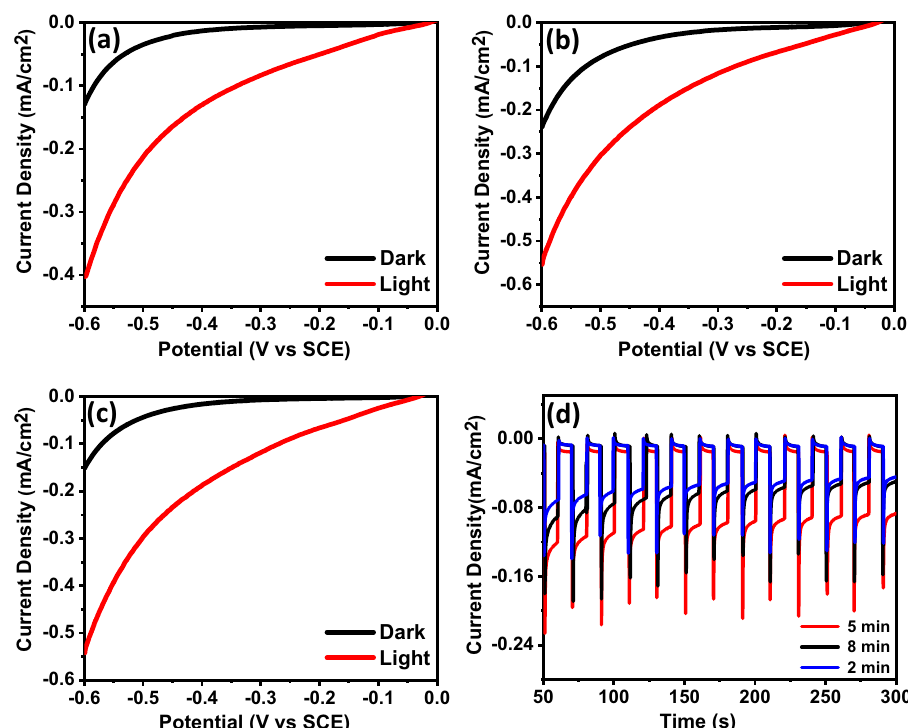
Figure 5. J–V and J–t curves of annealed Cu–Zn oxide photocathodes that anodized for ( a ) 2 min, ( b ) 5 min, ( c ) 8 min, and ( d ) the transient photocurrent